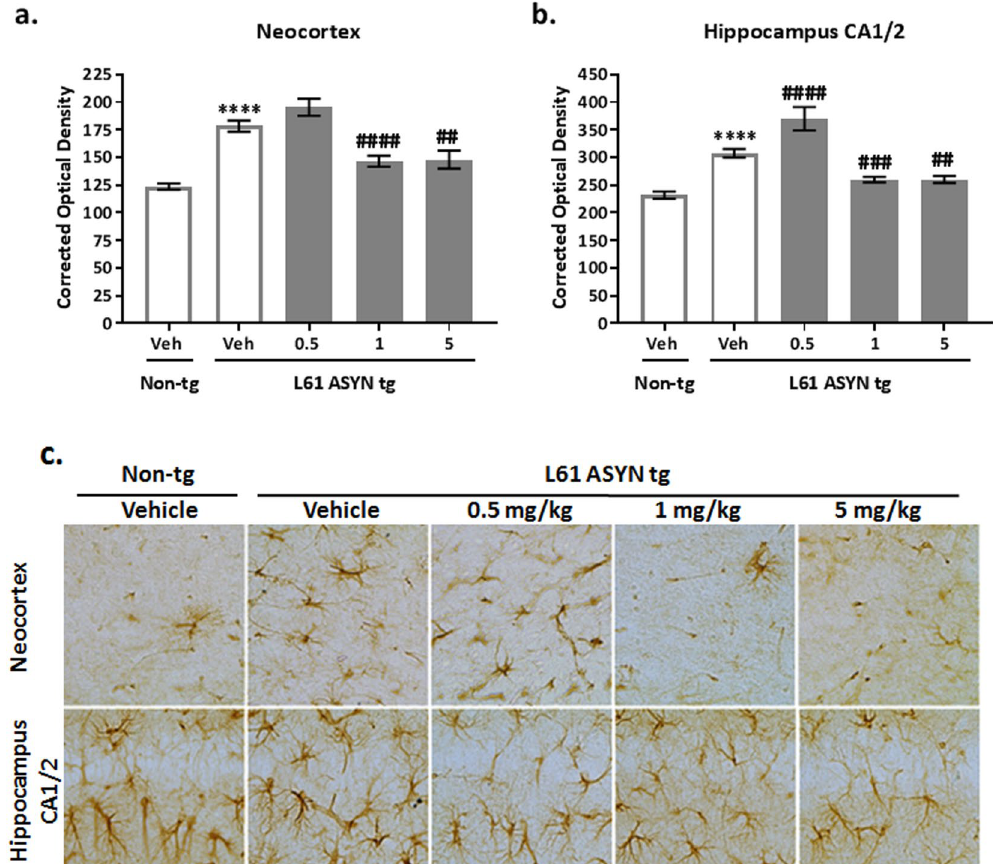
Figure 10. NPT200-11 treatment decreases GFAP immunolabeling in Line 61 ASYN transgenic mice. There was a statistically significant increase in GFAP immunolabeling in the ( a ) neocortex and ( b ) hippocampus CA 1/2 of Line 61 ASYN transgenic mice ( **** p < 0.0001 vs. vehicle-treated non-transgenic controls ). NPT200-11 administration produced statistically significant normalizations in GFAP immunolabeling in the ( a ) neocortex (1 and 5 mg/kg, #### p < 0.0001 and ## p < 0.01 vs. vehicle-treated Line 61 ASYN transgenic controls ) and ( b ) hippocampus (1 and 5 mg/kg #### p < 0.0001 , ### p < 0.001 and ## p < 0.01 and # p < 0.05 vs. vehicle-treated Line 61 ASYN transgenic controls ). An increase in GFAP levels was noted in the hippocampus of Line 61 ASYN transgenic mice treated with 0.5 mg/kg NPT200-11 ( #### p < 0.0001 vs. vehicle-treated Line 61 ASYN transgenic control group) . Representative images obtained at 40x are shown in ( c